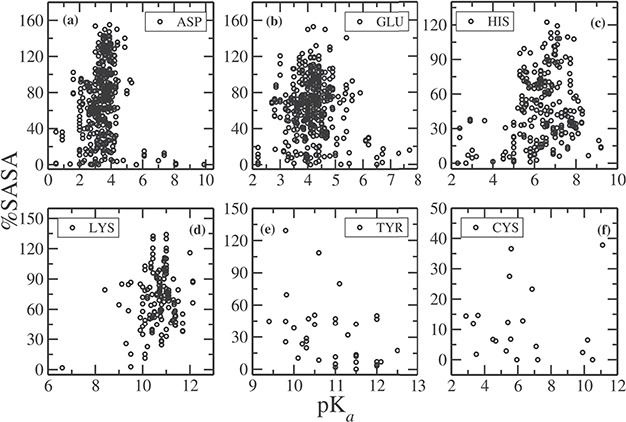
%SASA as a function of pKa for (a) ASP, (b) GLU, (c) HIS, (d) LYS, (e) TYR and (f) CYS.